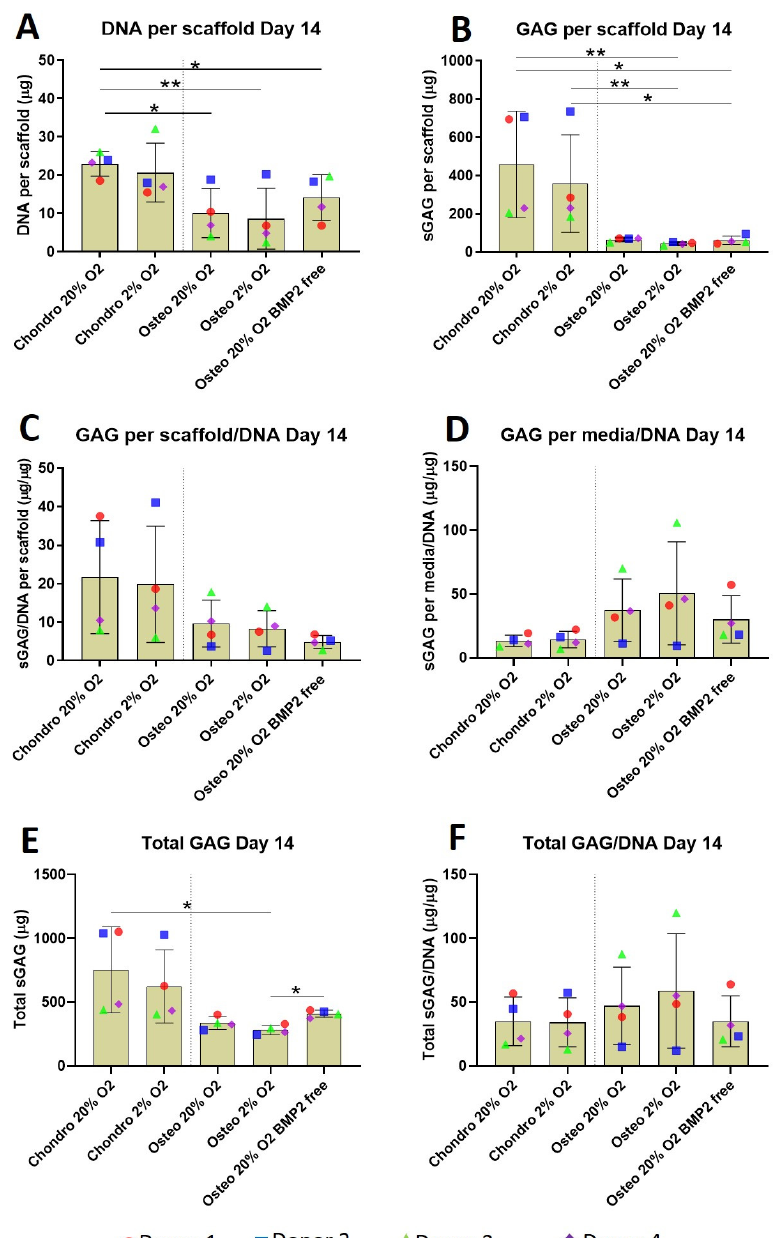
Figure 4. Biochemical analysis of chondrogenically and osteogenically differentiated constructs after 2 weeks in culture shows a significantly higher sulphated glycosaminoglycan deposition in chondrogenically differentiated constructs independent of oxygen tension. ( A ) Bisbenzimide Höchst 33528 dye was used to quantify the DNA in proteinase K digests of scaffolds. ( B – F ) Dimethyl- methylene blue (DMMB) at pH 3 was used to determine the sulphated glycosaminoglycan (GAG) produced by mesenchymal stem cells (MSCs): ( B ) sulphated glycosaminoglycan produced by MSCs and deposited inside the scaffold: ( C ) GAG/DNA per scaffold: ( D ) culture media GAG normalized to DNA: ( E ) cumulative GAG deposited into the scaffold and released in culture media; ( F ) Total GAG/DNA. Values represent the mean ± SD of four independent hBMSC donors in experimental triplicate or quadruplicate. Statistical significance was defined as * p < 0.05, and ** p < 0.01. After 14 days of differentiation, chondrogenically differentiated constructs consistently accumulated more sGAG inside the scaffolds compared with osteogenically differentiated constructs (Figure 4B). No oxygen tension or BMP2-related differences were